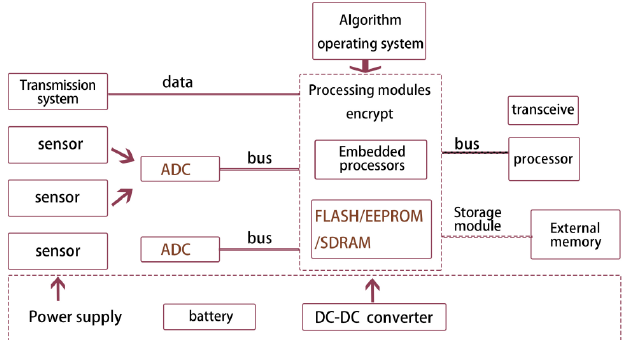
Figure 6. Hardware structure diagram of the wireless sensor node.